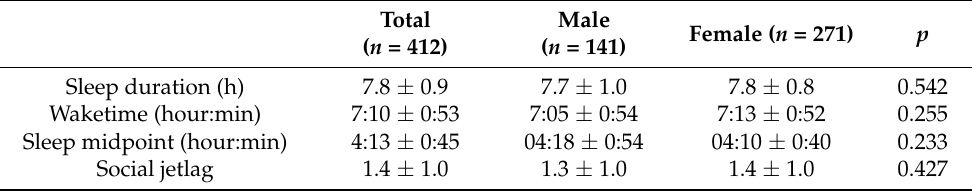
Table 2. Descriptive characteristics of sleep patterns in the whole sample and those per sex.